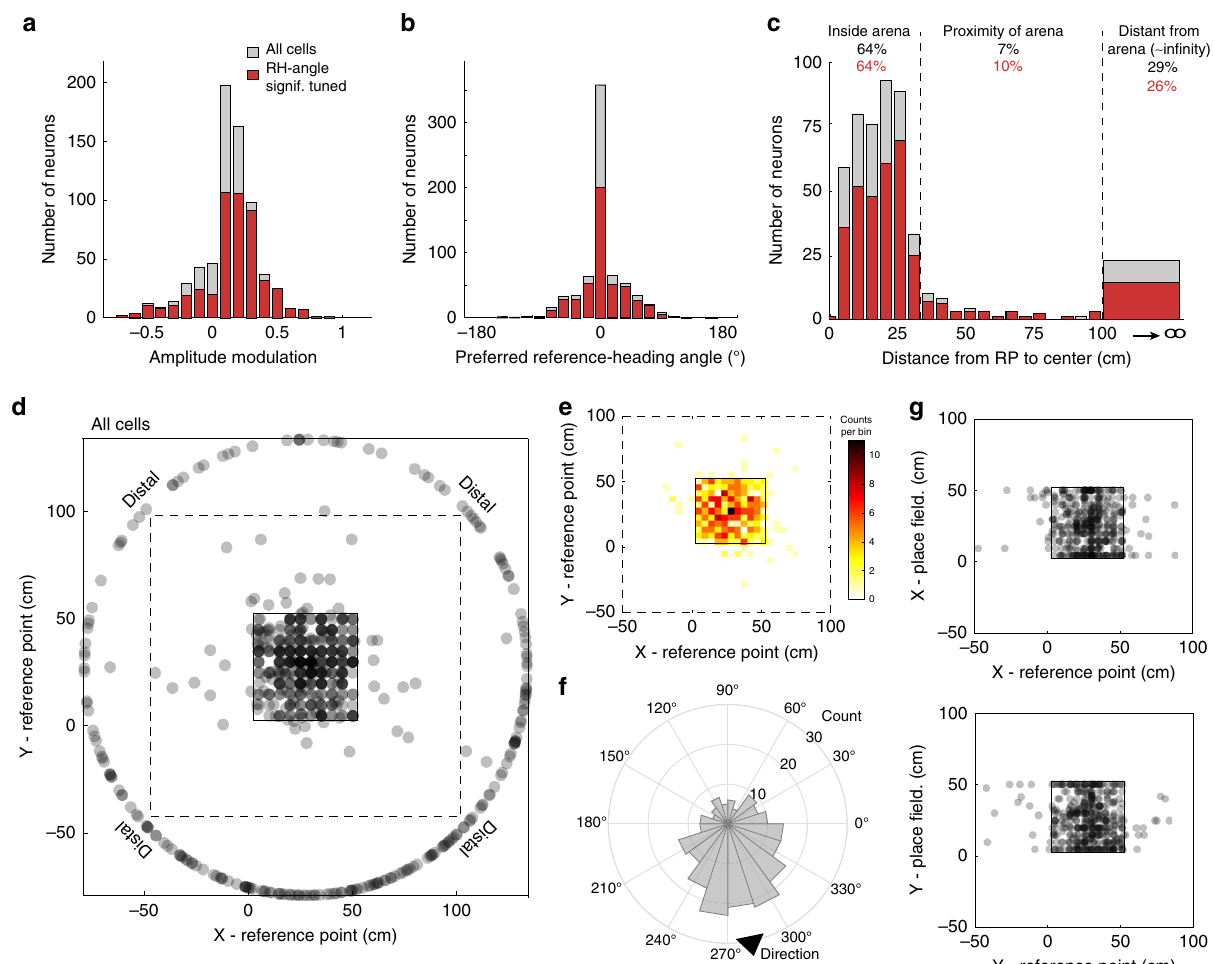
Fig. 3 Fitted model parameters across neurons. a Histogram of the amplitude of the angular modulation for all neurons and for neurons with signi fi cant reference-heading (RH)-angle tuning (neurons above the dotted line in Fig. 2b). b Histogram of the angle of the preferred RH direction. c Histogram of the distances of reference points from the center of the enclosure. d Reference points located within the enclosure (square in the center of the panel), in the proximity of the enclosure (dashed square), and at distal locations (collapsed onto a circle of 150 cm diameter). e Density map of reference point locations inside and near the enclosure. The concentration of reference points toward the center of the arena is not statistically signi fi cant. f Circular histogram of the direction to reference points at distal locations shows a signi fi cant concentration in the S-E direction (outside the 95% conf. interval). reference points within the box do not show any signi fi cant anisotropy. g Scatter plot of reference point coordinates ( x — top, y — bottom) compared to the coordinates of the centers of the place fi elds for each neuron. There is no correlation between the locations of the reference points and the place fi eld center of mass for the same